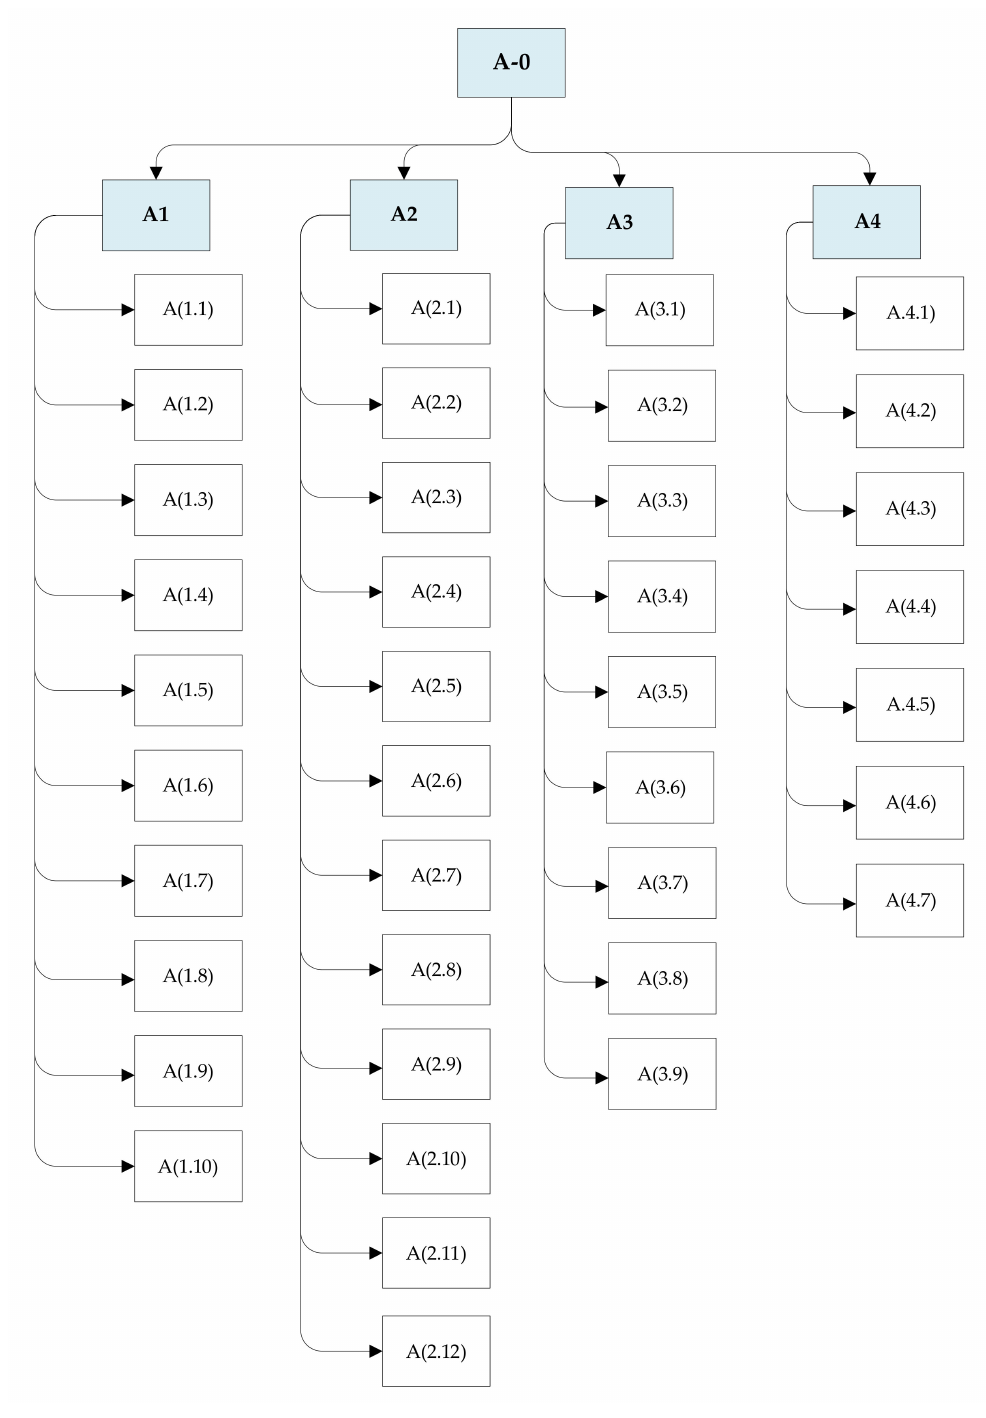
Figure 4. The hierarchy of the IDEF0 model Tree-View task